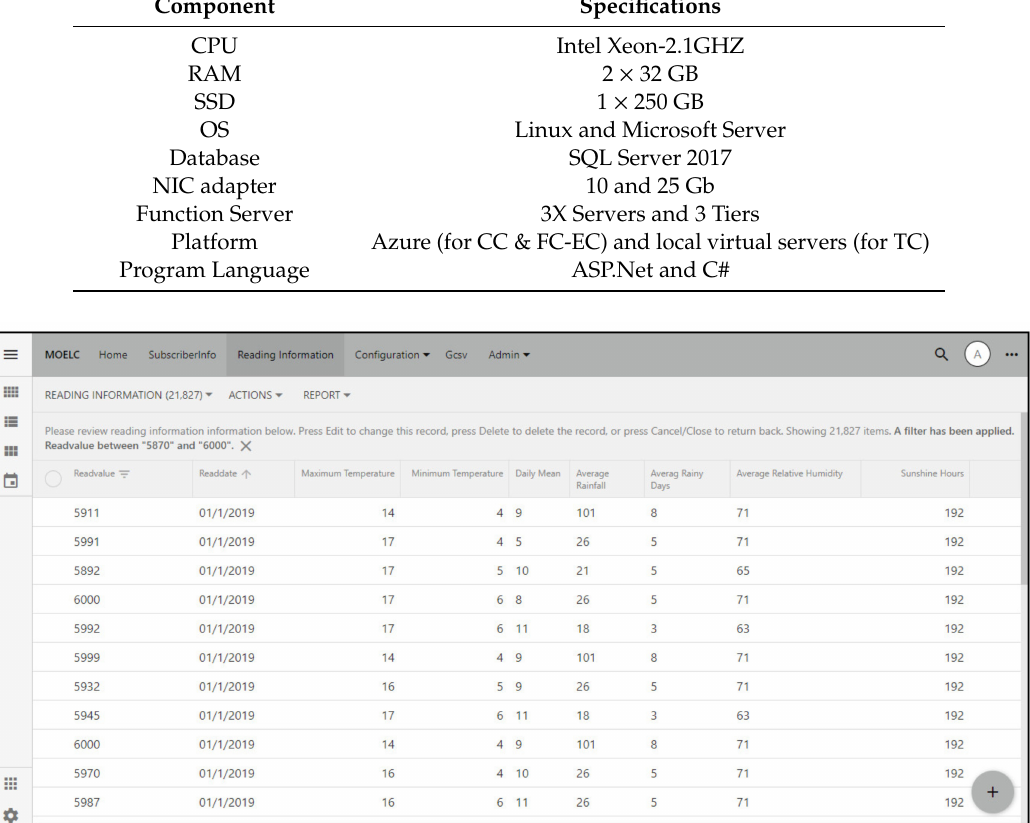
Figure 7. Improved system interface deployed in a laboratory environment for power consumption